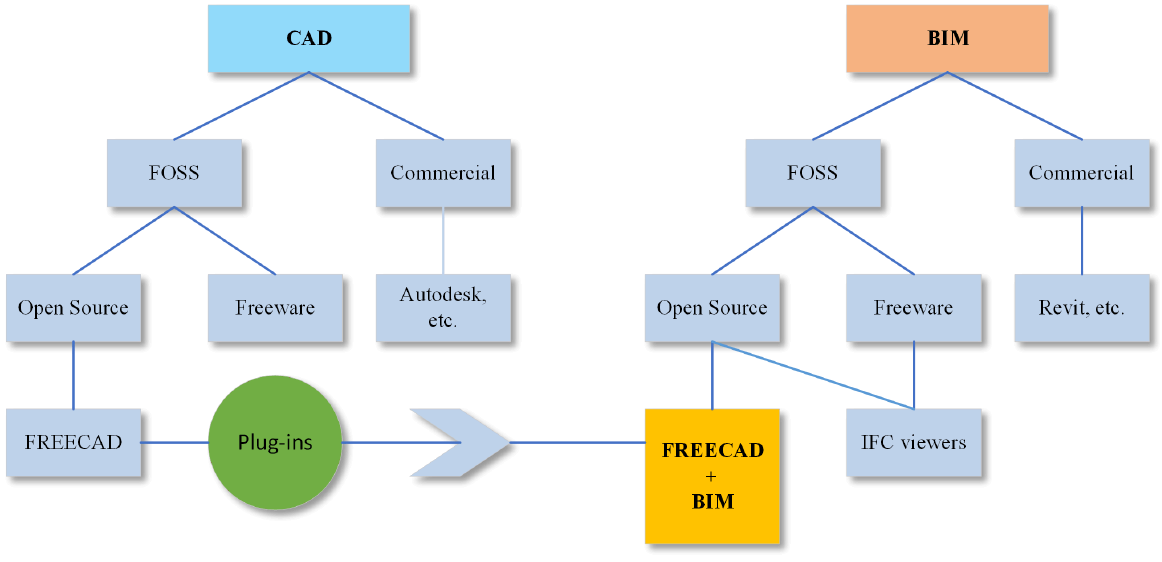
Figure 4. Concept of plugin